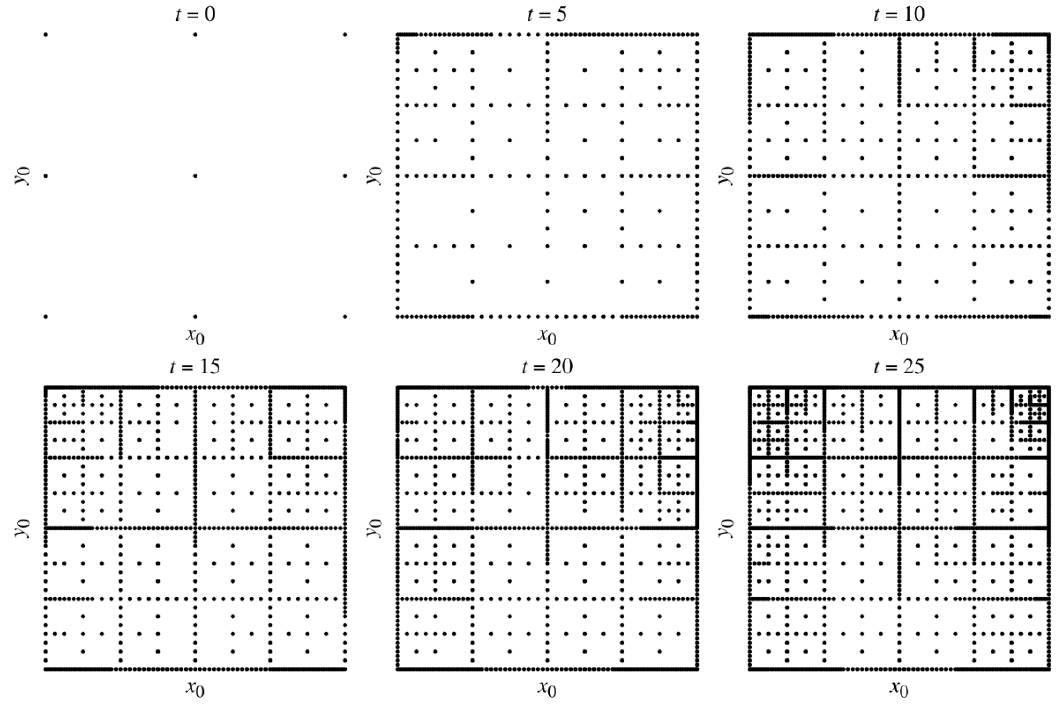
Figure 8. The interval solution of system given by Equation (9) at different moments of time.